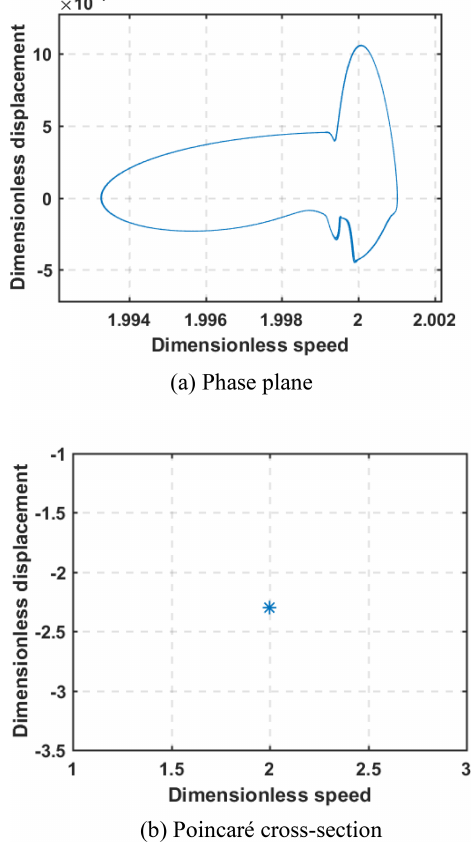
Figure 7. System response of w k = 45 Hertz.